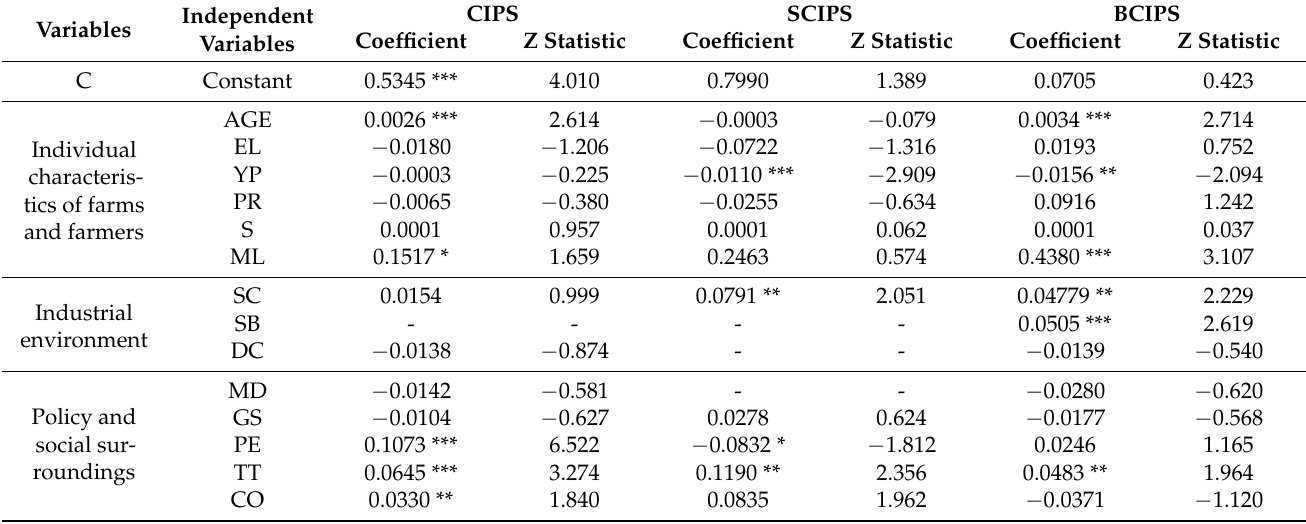
Table 7. Estimation Results of the Factors Influencing the Pure Technical Efficiency (PTE) of Different Beef Calf Production